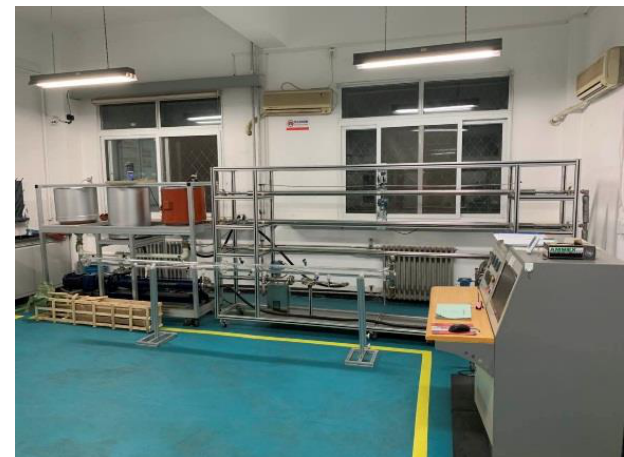
Figure 1. Picture of the loop friction test device.